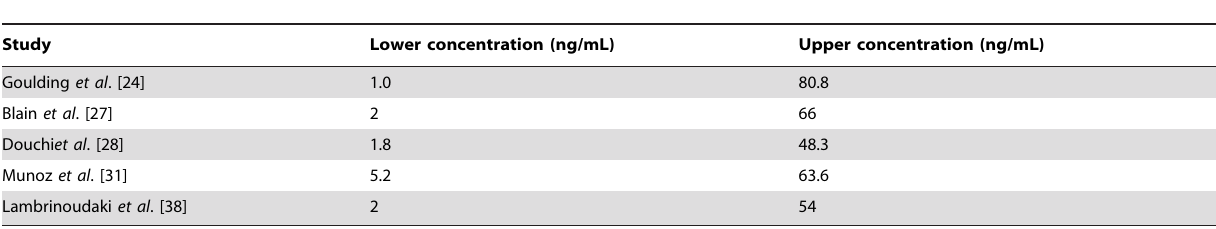
Table 2. Range of LCs of PW in the included